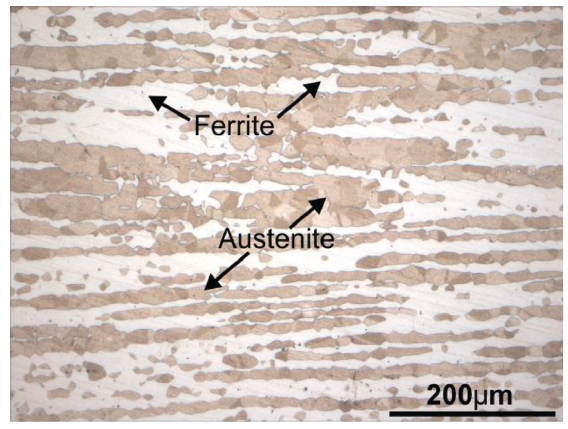
Figure 1: Microstructure of 2205 DSS held at 1373K for 1h.